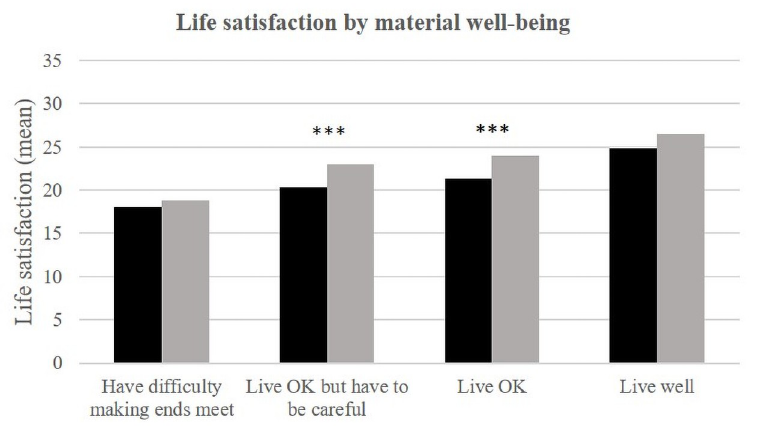
Fig 5. Life satisfaction (mean) by material well-being and place of life.